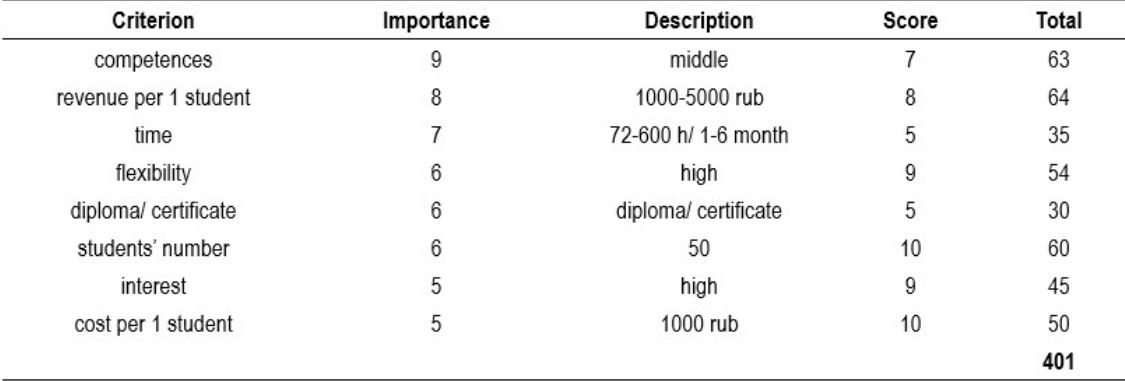
factors and their